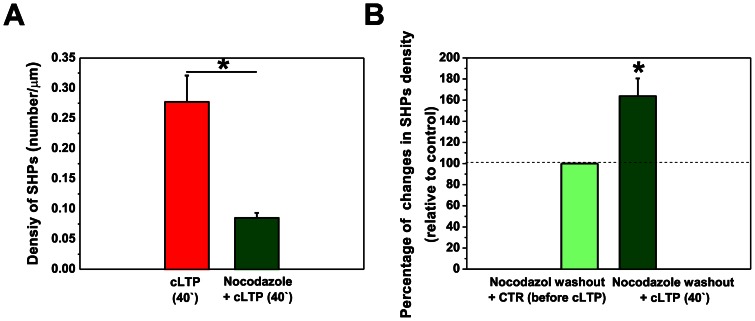
Dynamic microtubules are required for the development of SHPs upon cLTP.(A) Dissociated hippocampal cultures were preincubated with nocodazole (200 nM, for 4 h) to block neuronal microtubule dynamics and cLTP was then induced. Column bars show the quantification of SHPs (number/µm) under cLTP and nocodazole+cLTP conditions. Suppressing MT assembly/disassembly with nocodazole significantly reduced SHP density compared with the density measured after 40 min of cLTP. (B) Column bars show the quantification of SHPs (number/µm) in nocodazole washout experiments. The cultures were incubated with 200 nM nocodazole for 4 h, and nocodazole was then washed out. The cultures were kept in culture medium for 3 h, and cLTP was then induced. Blocking dynamic MTs with nocodazole followed by washout restored SHPs and significantly increased SHP density compared with unstimulated controls. The histograms show the mean ± SEM. *p<0.05.